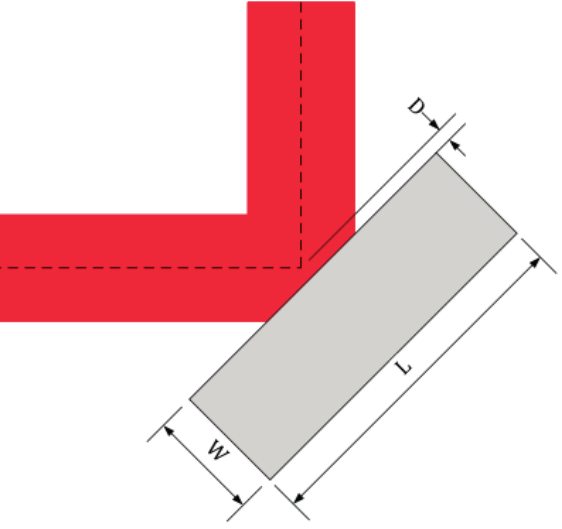
Figure 5. 90° trench-based bend geometry of SOI rib waveguide with large cross